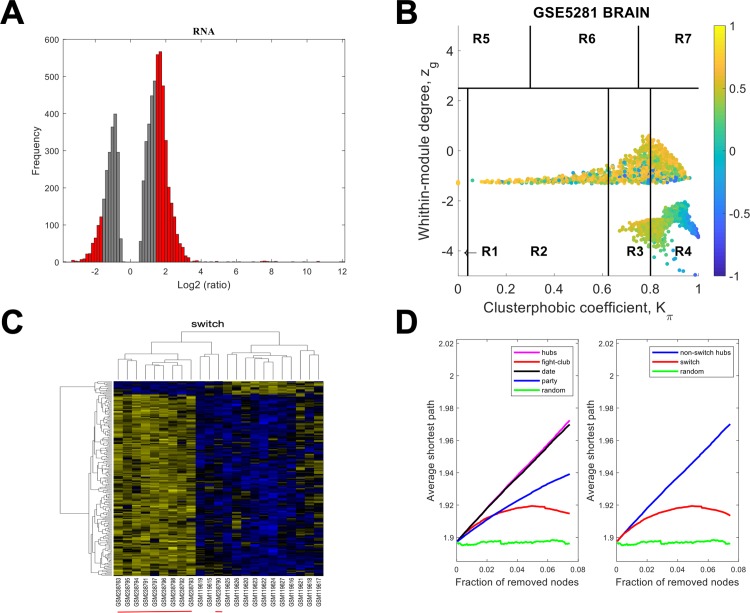
SWIM analysis of the entorhinal cortex.A. Distribution of the fold-change values for GSE5281 brain microarray gene expression data from the EC. The x-axis represents the fold-change value (log2 of the fold-change) that is the ratio of the average expression data in AD patients compared to the average expression data in normal controls computed for protein-coding and non-coding RNAs. The y-axis represents the frequency of the obtained fold-change values. The grey bars represent the fold-change values associated with protein-coding and non-coding RNAs that will be discarded according to the selected threshold. The red bars represent the fold-change values associated with protein-coding and non-coding RNAs that were retained for further analysis. B. Heat cartography map for GSE5281 brain data from the entorhinal cortex correlation network. The plane is identified by two parameters: Zg (within-module degree) and Kπ (clusterphobic coefficient) and it is divided into seven regions each defining a specific node role (R1-R7). High Zg values correspond to nodes that are hubs within their module (local hubs), whereas low Zg values correspond to nodes with few connections within their module (non-hubs within their communities, but they could be hubs in the network). Each node is colored according to its average Pearson Correlation coefficient (APCC) value. Yellow nodes are party and date hubs, which are positively correlated in expression with their interaction partners. Blue nodes are the fight-club hubs, which have an average negative correlation in expression with their interaction partners. Blue nodes falling in the region R4 are the switch genes, which are characterized by low Zg and by high Kπ values and are connected mainly outside their module. C. Dendrogram and heat map for switch genes in GSE5281 brain microarray gene expression data from the entorhinal cortex. The expression profiles of switch genes (including protein-coding and non-coding RNAs) are clustered according to rows (switch genes) and columns (samples) of the switch genes expression data (biclustering). The colors represent different expression levels that increase from blue to yellow. The red line under the x axis labels denotes AD samples. D. Robustness for the GSE5281 brain correlation network from the entorhinal cortex. The x-axis represents the cumulative fraction of removed nodes, while the y-axis represents the average shortest path. The shortest path between two nodes is the minimum number of consecutive edges connecting them. Each curve corresponds to the variation of the average shortest path of the correlation network as function of the removal of nodes specified by the colors of each curve.